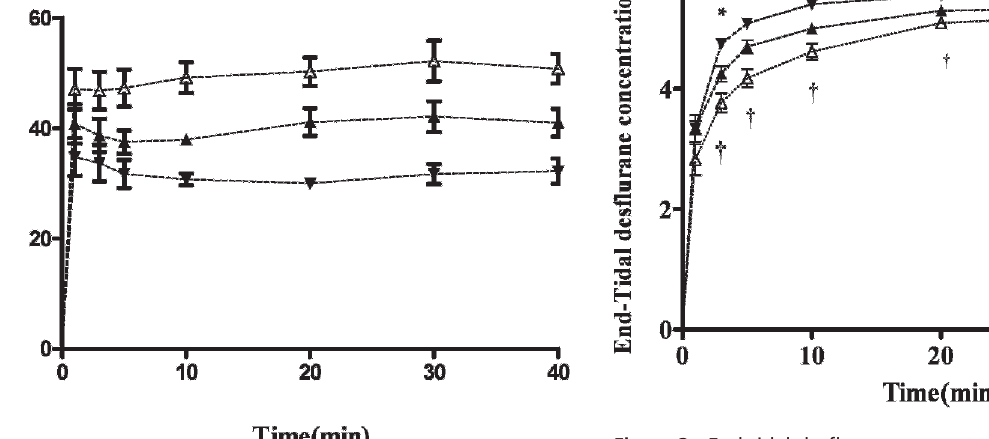
Figure 1 - End Tidal CO 2 concentration (ETCO 2 ) time curves under three different ventilatory states, including hyperventilation (-- . --), normal ventilation (-- m --),and hypoventilation (-- g --) during 40 minutes of study.Data are presented as the mean ¡ standard deviation.